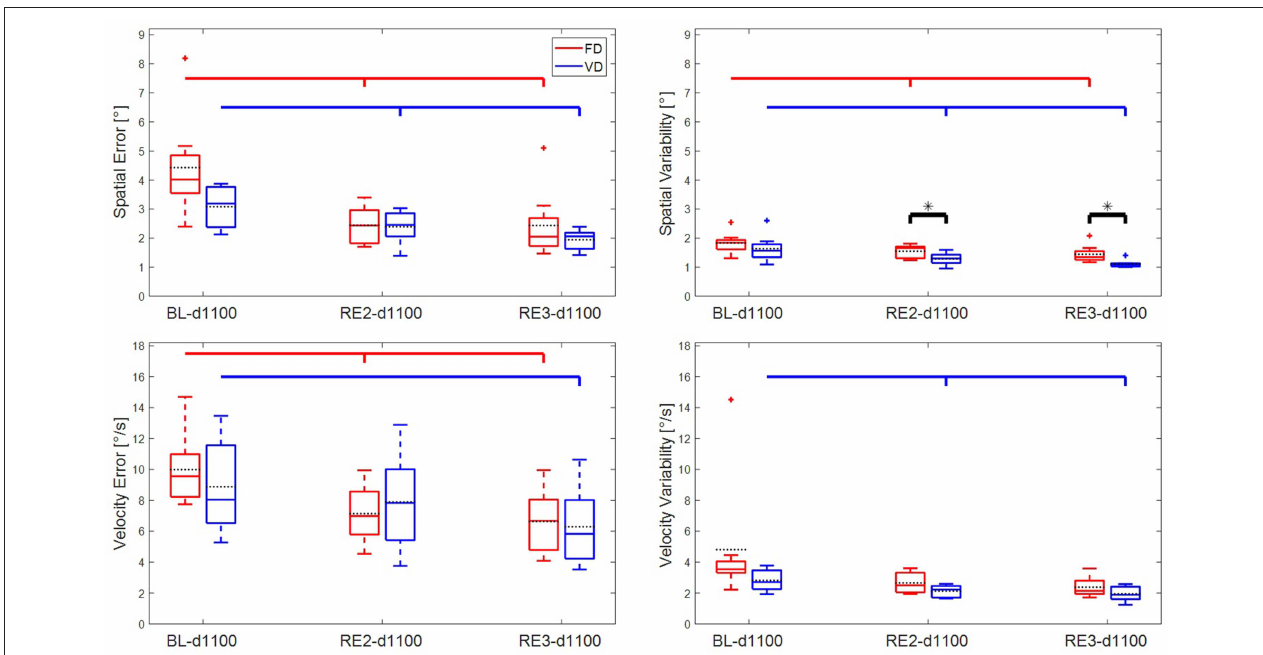
FIGURE 4 | Main outcome metrics vs. main condition tests for all subjects of the two groups: spatial error (Upper Left) , spatial variability (Upper Right) , velocity error (Lower Left) , and velocity variability (Lower Right) . The boxes in group color denote median and the edges of the box are the 25 and 75th percentiles. Group means are shown by black dashed line. The whiskers denote ± 2.7 standard deviations or 99.3% coverage intervals. Plus ( + ) symbols shown in the corresponding group colors indicate the outliers. Black starred (*) bars illustrate the main effect of group in the respective test run. The main effect of Time within each group are indicated by horizontal lines that are shown in the corresponding group color. Significant differences from BL-d1100 to RE2-d1100 and BL-d1100 to RE3-d1100 are denoted by vertical marks below the horizontal lines.